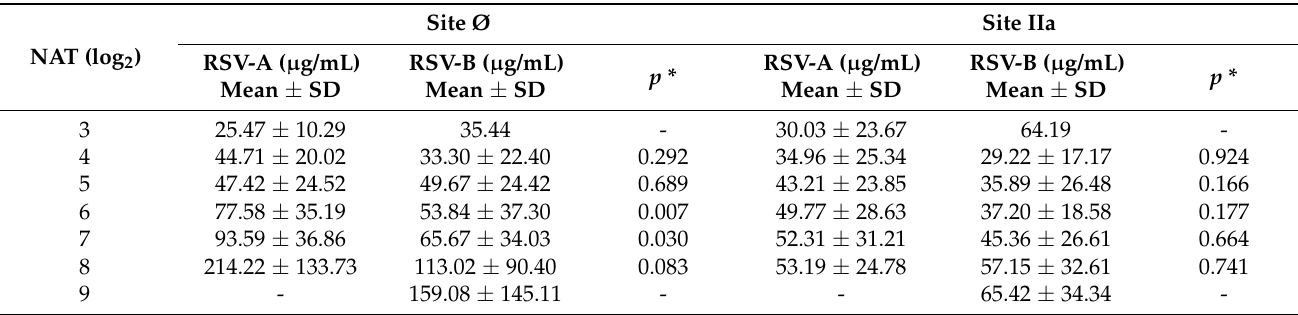
Figure 5. Relationship between NATs and ESAs in maternal blood. In total, 87 MB samples were evaluated for ESAs. The graph is shown as a box plot, showing the range of the 1st and 3rd quartiles as well as the maximum and minimum values. The polygonal line represents the average ESA levels at each NAT. ( a ) Relationship between the levels of ESAs specific to sites Ø and IIa and NATs against RSV type A in MB. ( b ) Relationship between the levels of ESA specific to sites Ø and IIa and NATs against RSV type B in MB. Pearson’s product-moment correlation. Table 4. Concentration of ESA at each